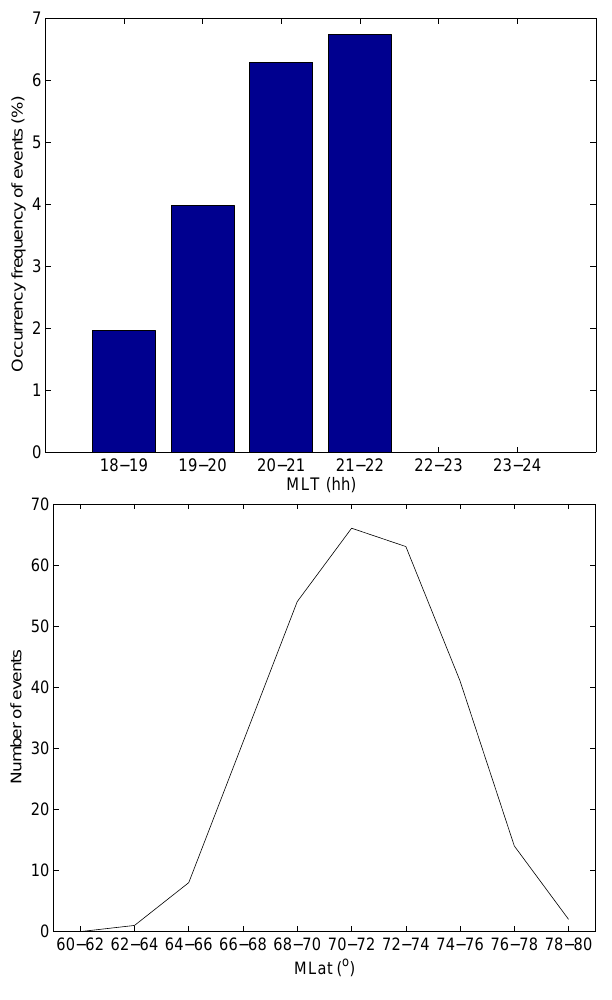
Fig. 3. Distribution of fast plasma jets. Top shows the occurrence frequency of convection jets as a function of MLT. Bottom shows the number of events as a function of MLat.